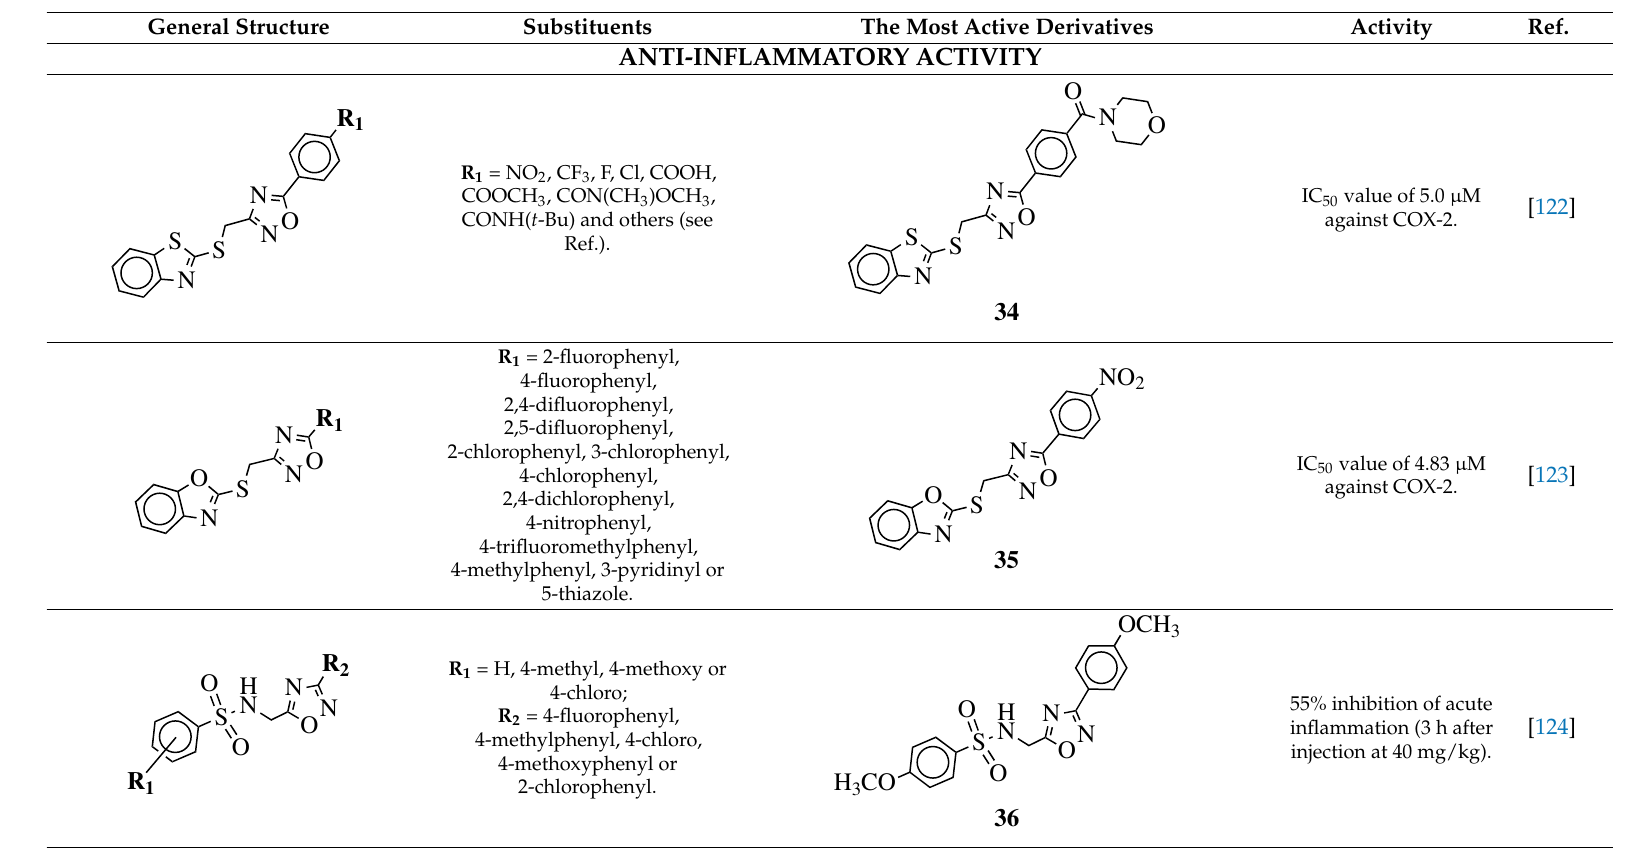
Table 4. 1,2,4-oxadiazole derivatives and their antimicrobial